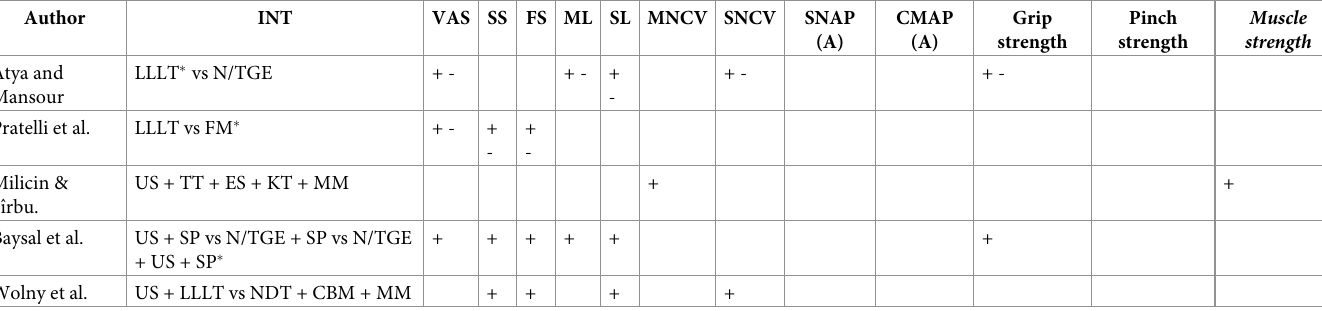
Table 2. Outcome measures and significance of electrophysical modalities versus manual